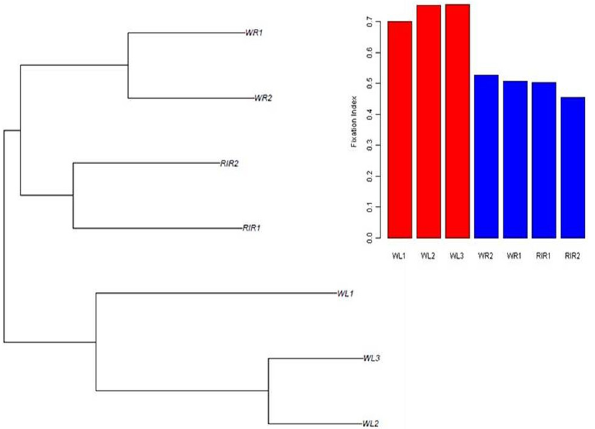
Fig 1. Reynolds ’ genetic distances population tree of seven commercial breeds and histogram of fixation index for each line.